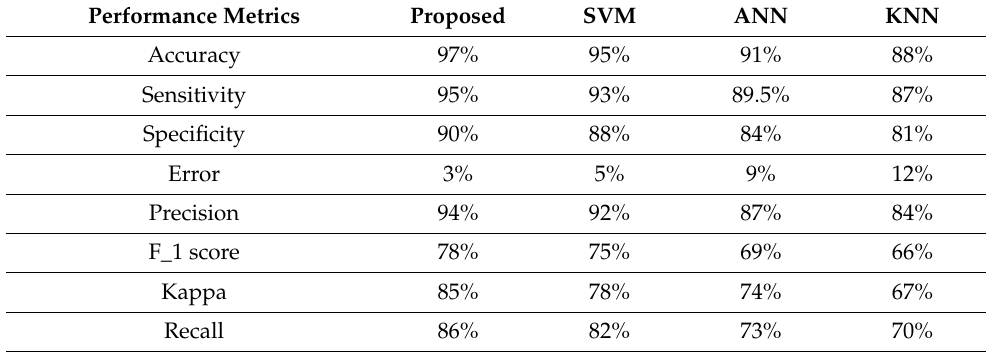
Table 3. Performance analysis of proposed and previous